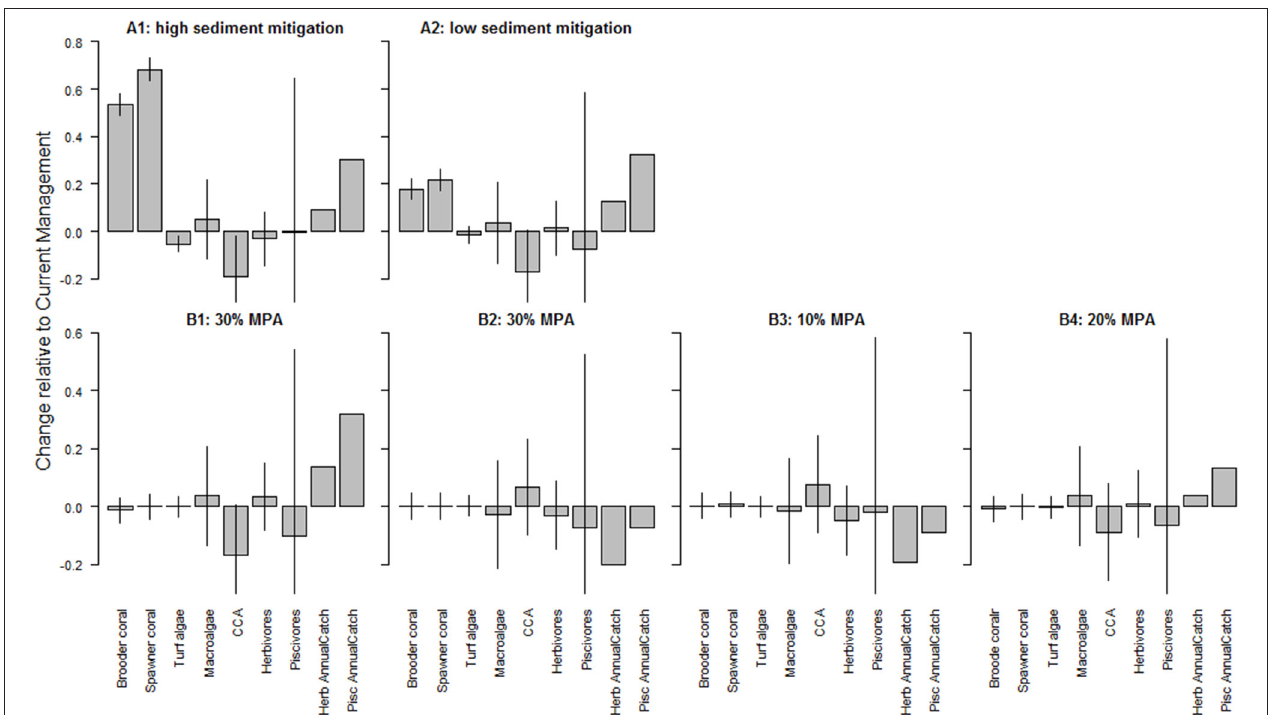
FIGURE 4 | Changes in benthic cover (corals and algae) and fish (herbivores and piscivores) biomass compared to Current Management as a result of local management including ( top row ) high (A1) and low (A2) sediment mitigation and ( bottom row ) additional MPA establishments with B1 and B2 additional 30% randomly selected MPAs, B3 10% additional MPAs and B4 20% additional MPAs. A value of 0 indicates no change from the outcome in 2050 under Current Management, values > 0 indicate an improvement (or, more accurately, less of a decline from the Current Management), while values < 0 indicate a worsening of the decline relative to Current Management. The bars represent ± 1 standard error as a percentage of the mean. Annual catch was calculated post model simulations based on the results of cumulative catches of the 50 simulations per scenario and hence has no error bar. CCA is crustose coralline